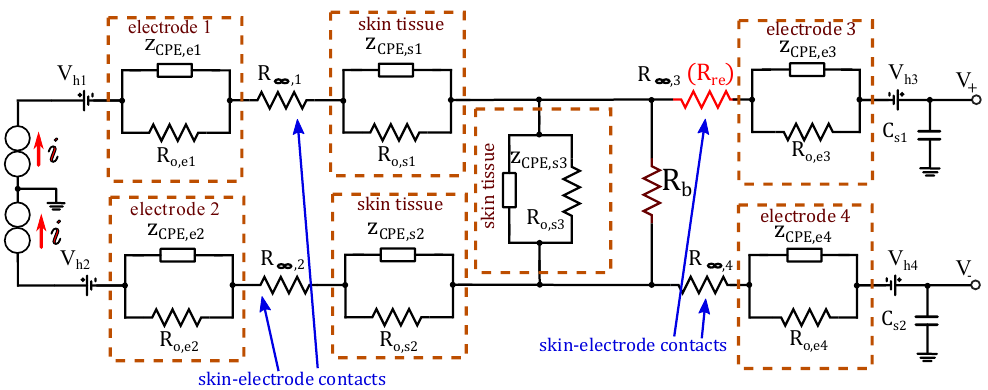
Figure 27. Tetrapolar setup cases.